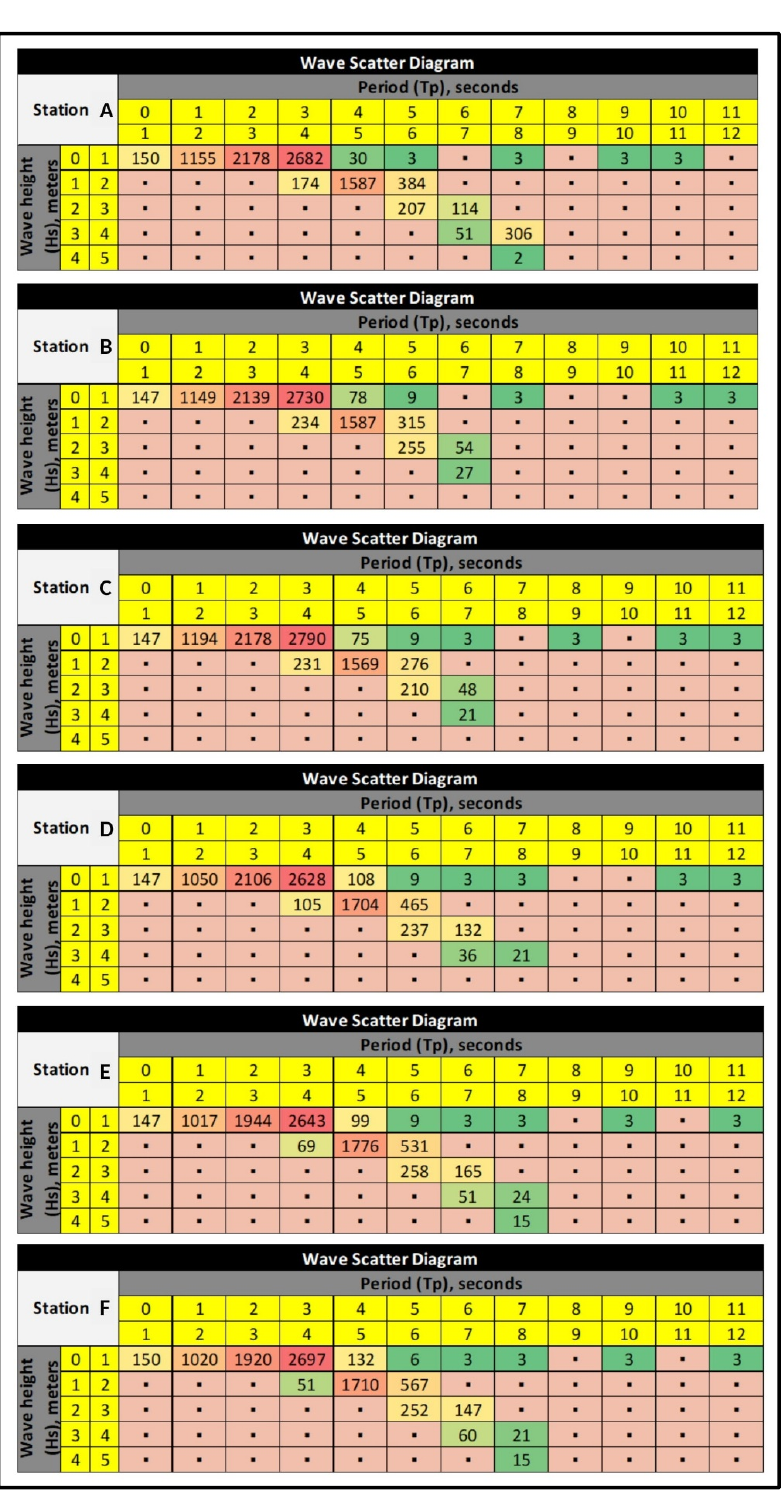
Figure A1. Wave scatter diagram of stations A–F.